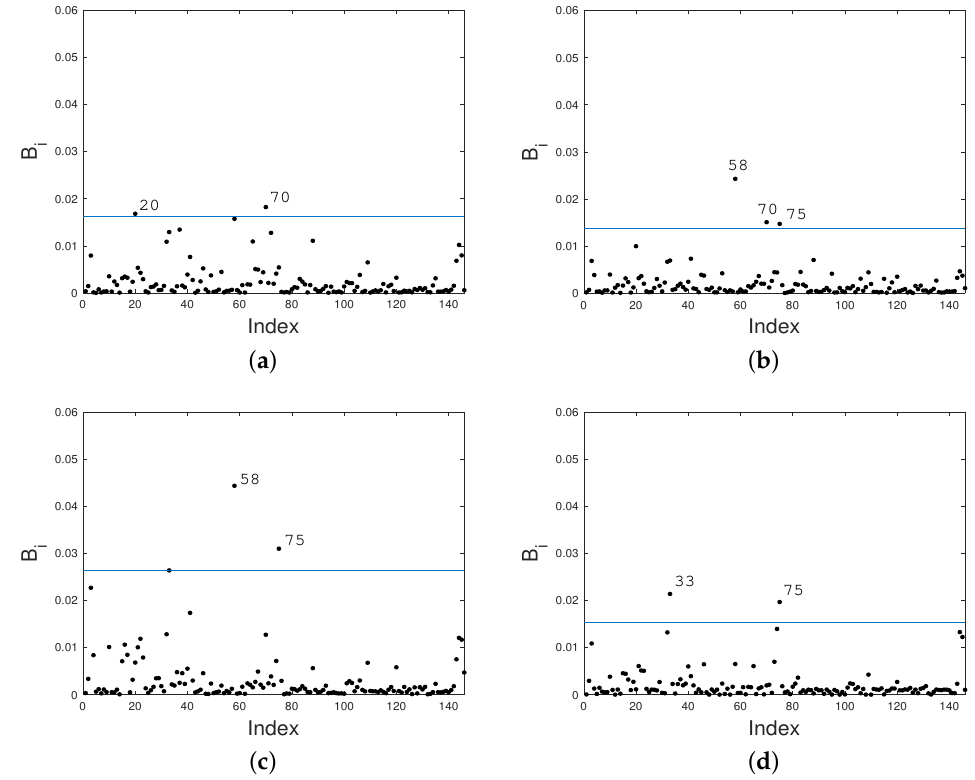
Figure 7. Index plots of B i for assessing local influence on (cid:98) α ( a ); (cid:98) β 1 ( b ); (cid:98) β 2 ( c ); and (cid:98) φ ( d ) under case-weight perturbation for fitted Student-t PVCM (Santiago